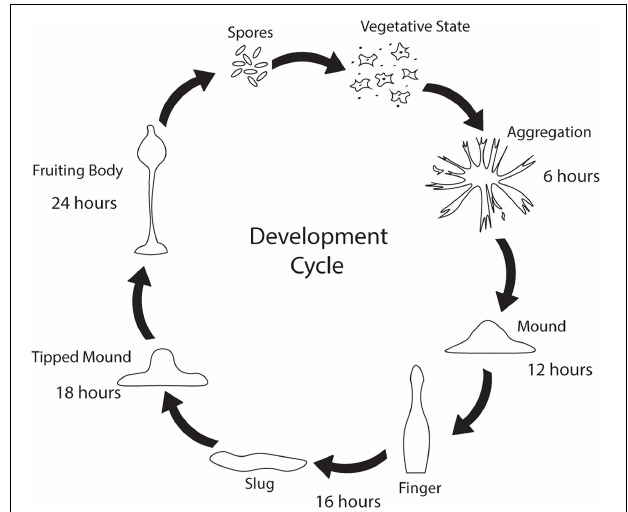
FIGURE 1 | Dictyostelium’s developmental cycle. Under stress conditions such as starvation, unicellular Dictyostelium emits a cAMP signal causing individual cells to culminate, forming aggregates after 6 h. After 12 h, the aggregates begin to form mounds which turn into finger/slug structures around 16 h. The slug carries the Dictyostelium cells to the top of the forest floor where it forms a tipped mound around 18 h. After 24 h, a fruiting body consisting of a spore filled sorus is hoisted by a stalk. Fruiting bodies are then carried off by wildlife and can germinate and propagate elsewhere.